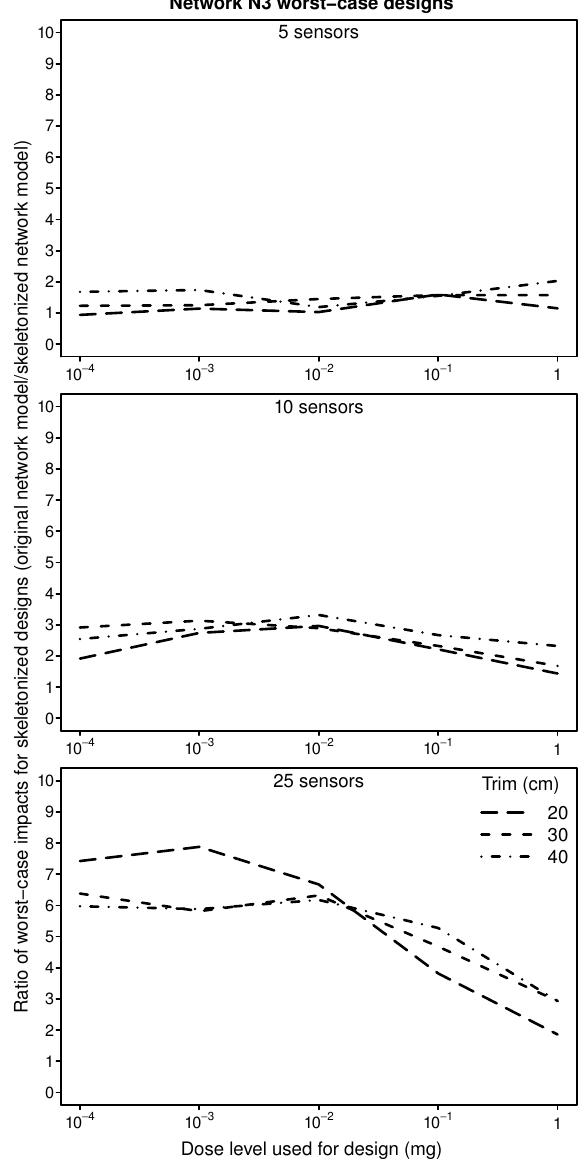
Figure 5. Worst-case impact versus dose level for original and transplanted, worst-case CWS designs for Network N3. Results are shown for the original model and three levels of network skele- tonization (trims).